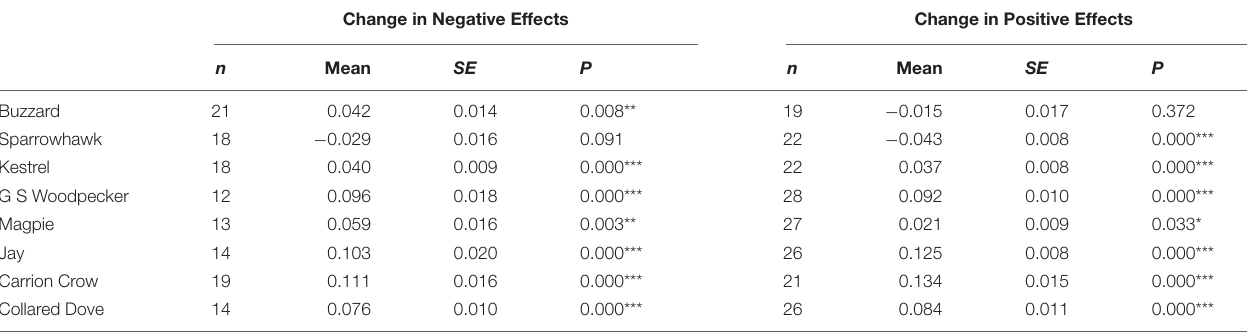
TABLE 3 | Mean change in estimated effects of predators on prey species following deletion of biomass from the linear model. Change in Negative